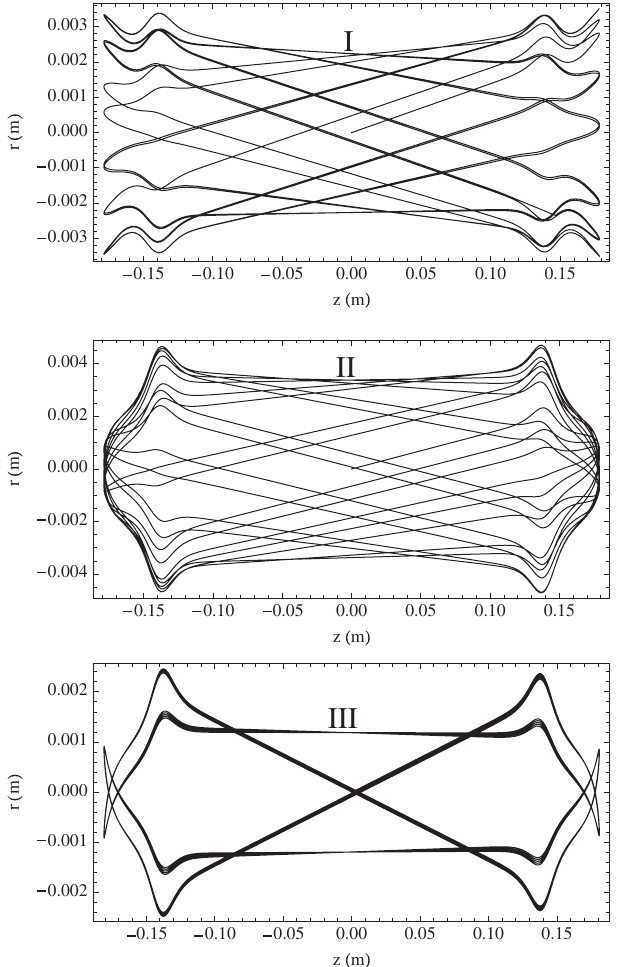
FIG. 11. Trajectories of O 4 þ at 5.2 kV. (top) Stability zone I: ¼ 7500 V , V ¼ 5850 V , V ¼ 4150 V , V ¼ 1650 V , ( V 1 2 3 4 ¼ 3650 V ). (middle) Stability zone II: ( V ¼ 6500 V , V ¼ V z 1 2 ¼ 4150 V , V ¼ 1650 V , V ¼ 4950 V ). (bottom) 5850 V , V z 3 4 ¼ 5100 V , V ¼ 5850 V , V ¼ 4150 V , Stability zone III: ( V 1 2 3 ¼ 1650 V , V ¼ 5400 V V z 4